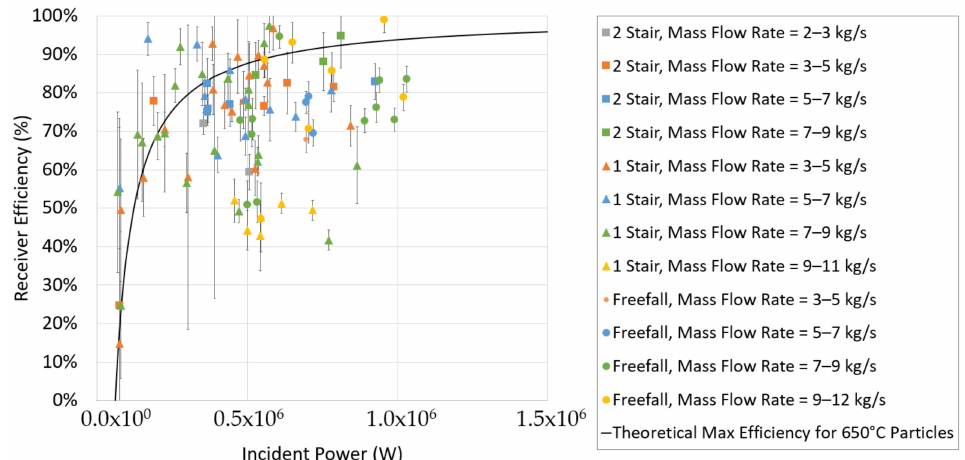
Figure 10. Plot of receiver efficiencies for on-sun StAIR (multistage) tests including free-falling tests and a theoretical maximum efficiency (solid black line) at 650 ◦ C (note: tests conducted at lower temperatures could yield higher efficiencies than theoretical maximums). Adapted from